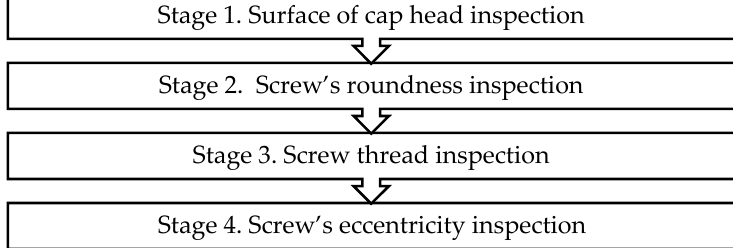
Figure 1. Full inspection workflow.